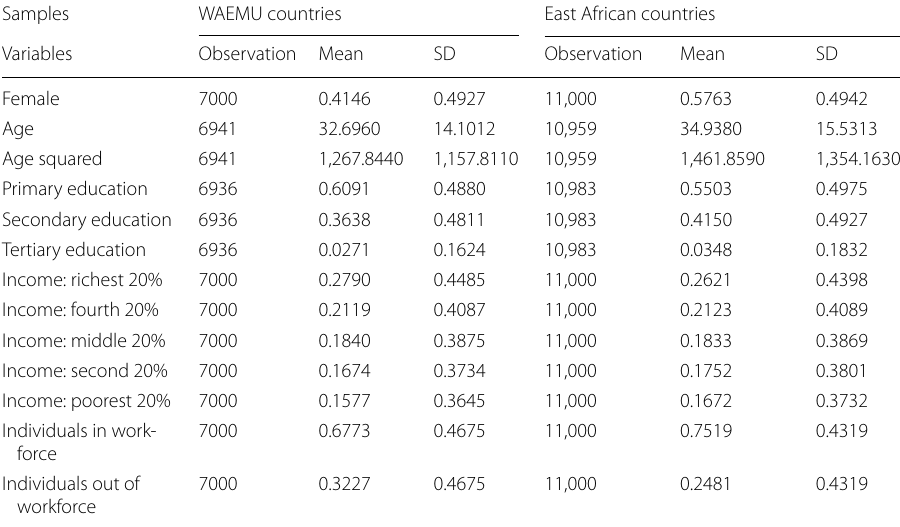
Table 4 Descriptive statistics of the explanatory variables. Source : Author’s